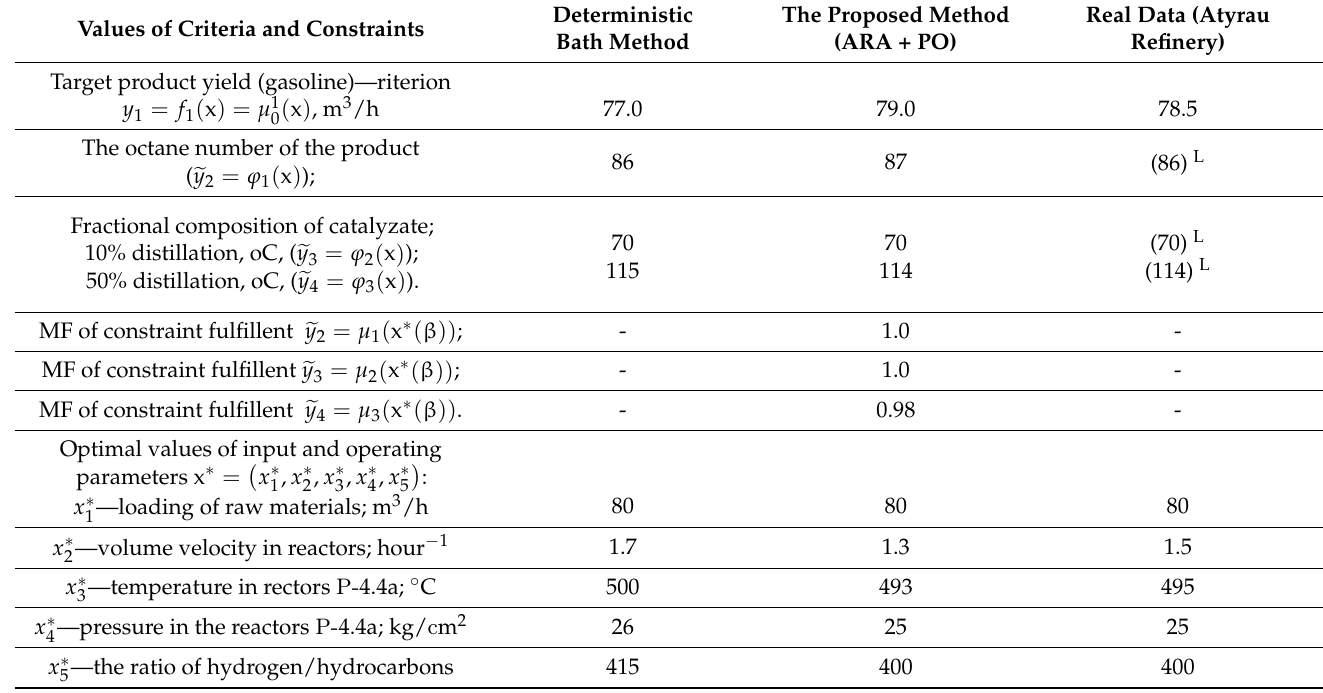
Table 3. Comparison of optimization results according to the proposed algorithm, according to the deterministic method [34] and real